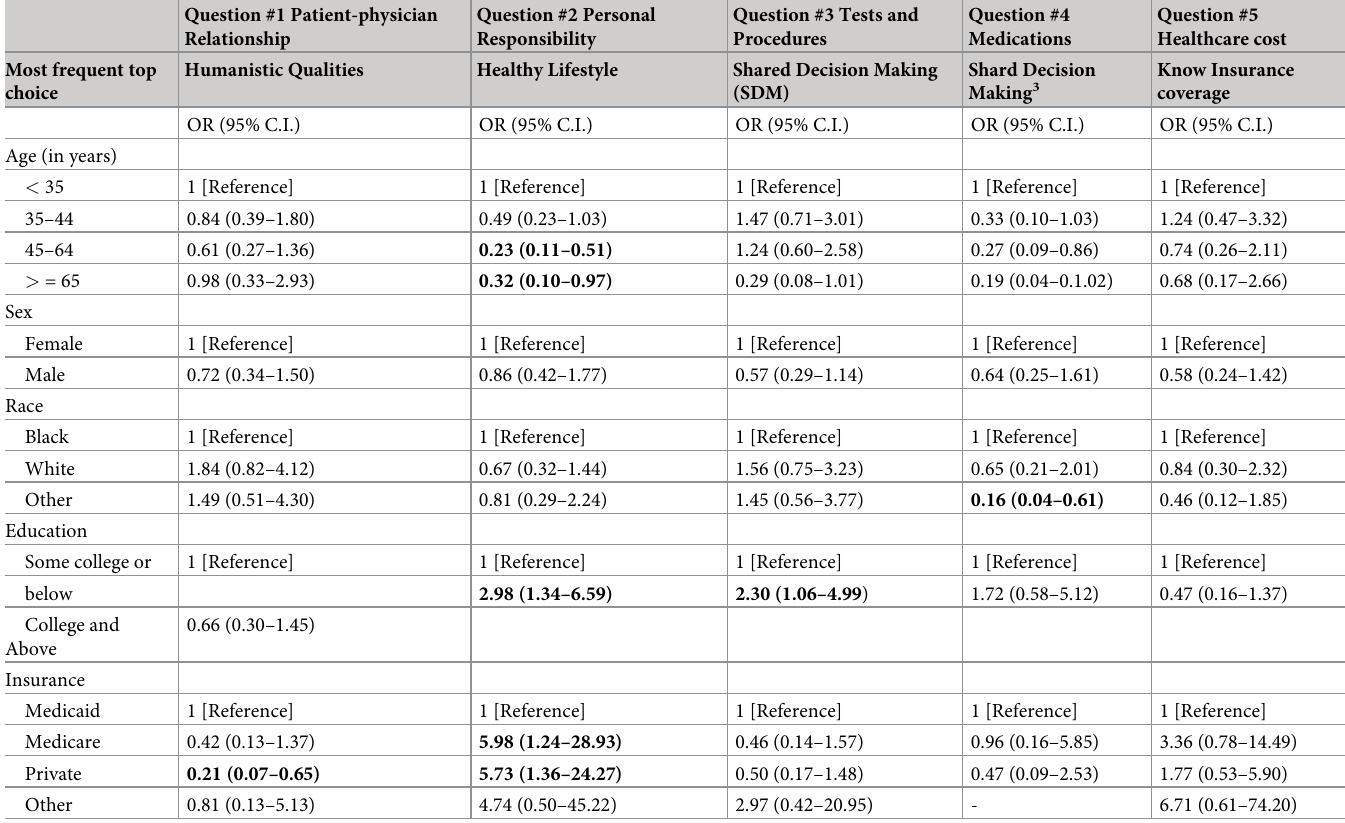
Table 5. Multivariate analysis for predictors of most frequent top choice for each